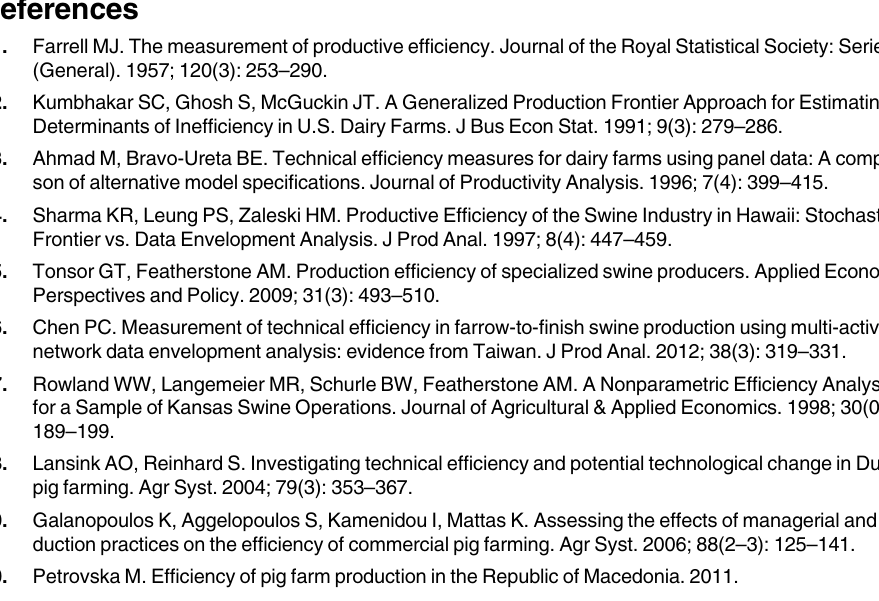
S2 Table. Input and output indicators for sows in China for 2008–2019. S3 Table. Input and output indicators for piglets in China for